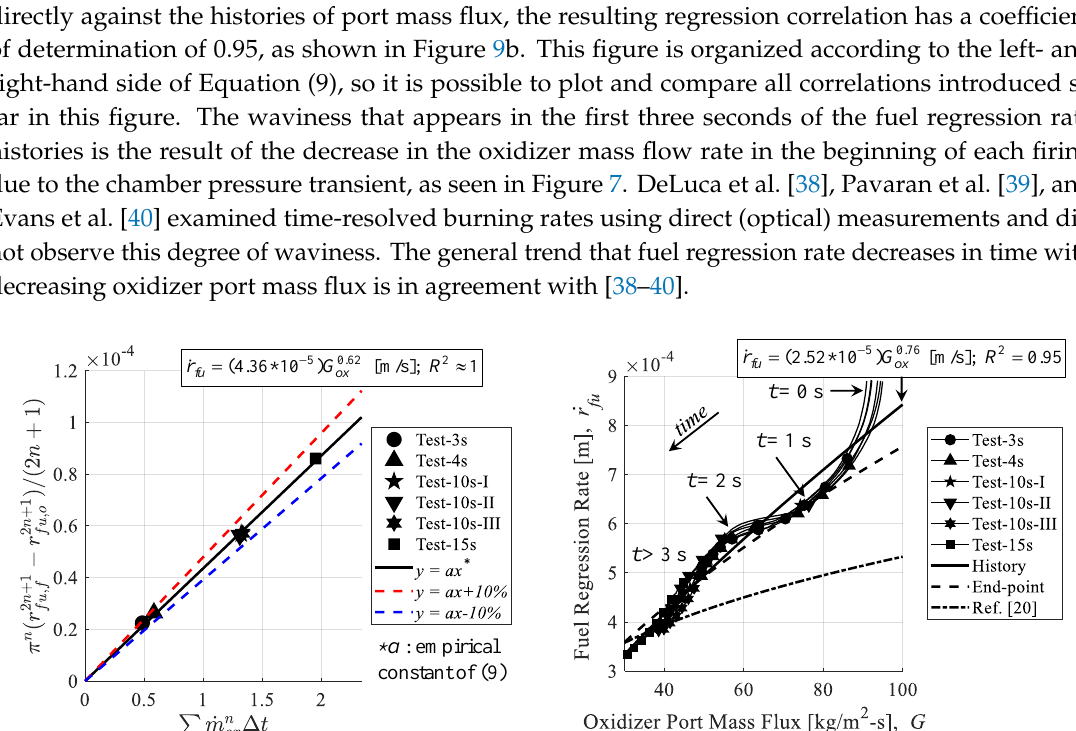
Table 2. Summary of tier II (NTRT+) and tier III (TTRT) results. 480